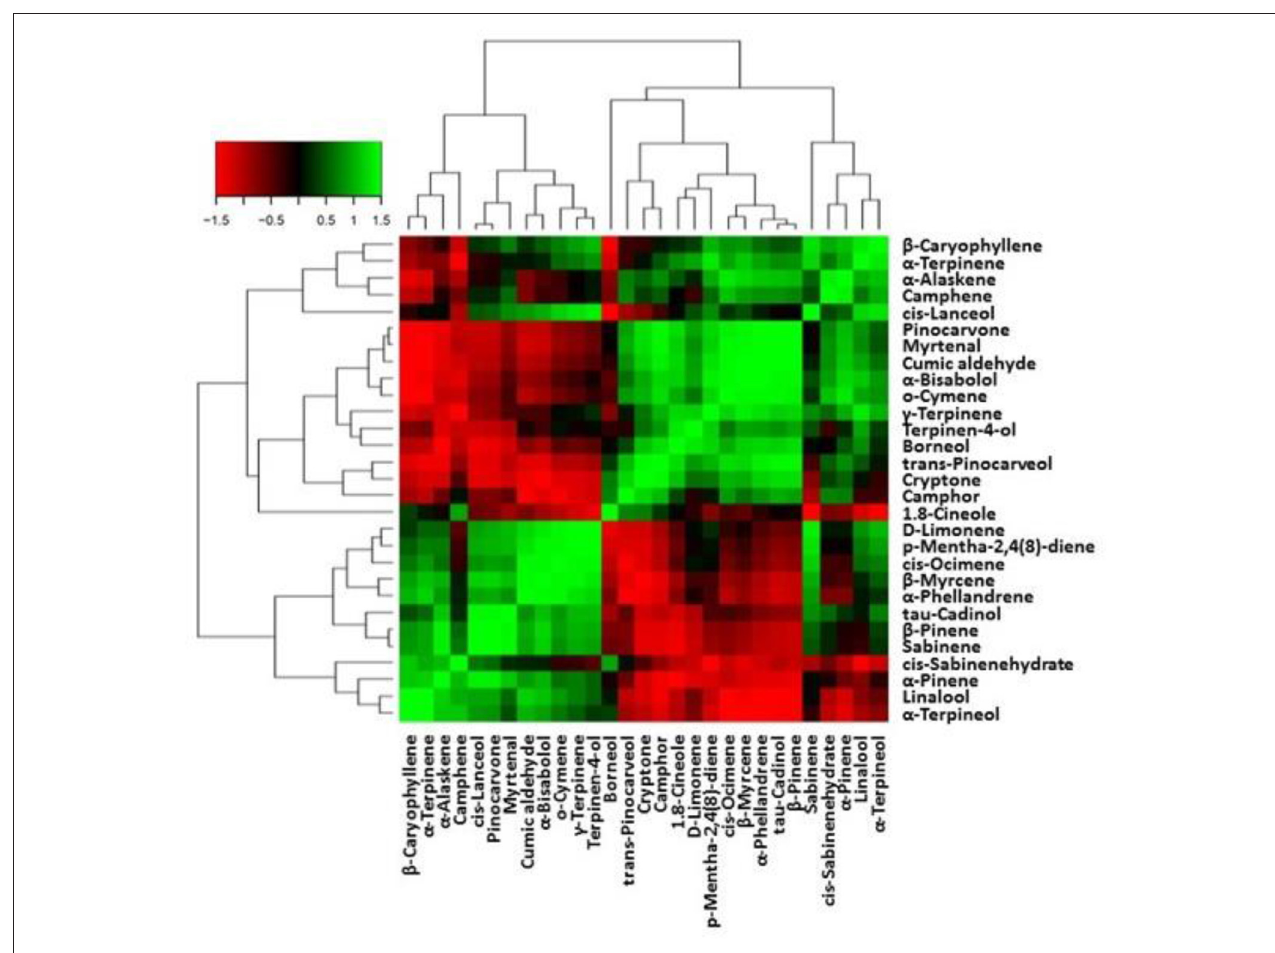
FIGURE 6 | Heat-map matrices of the correlation between EO metabolites in leaves of lavender. Each square indicates r (Pearson’s correlation coefficient of a pair of metabolites).